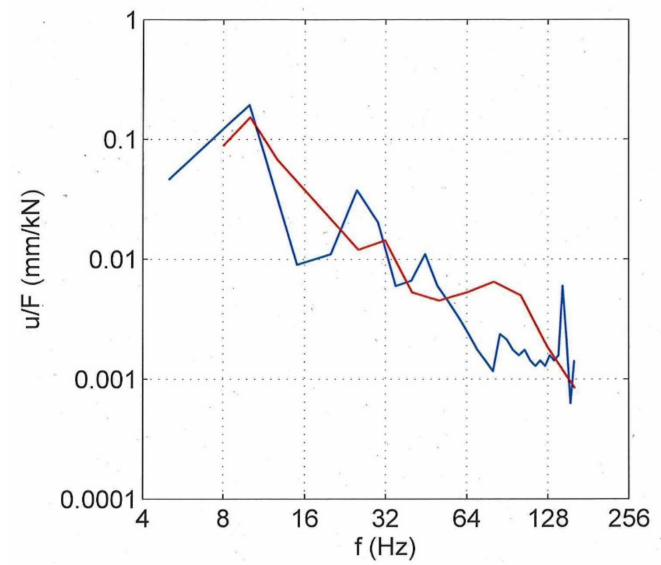
Figure 18. Transfer functions (receptances) of the floating-slab track with steel springs and viscous dampers: measurement (red) calculation (blue, FEM results).